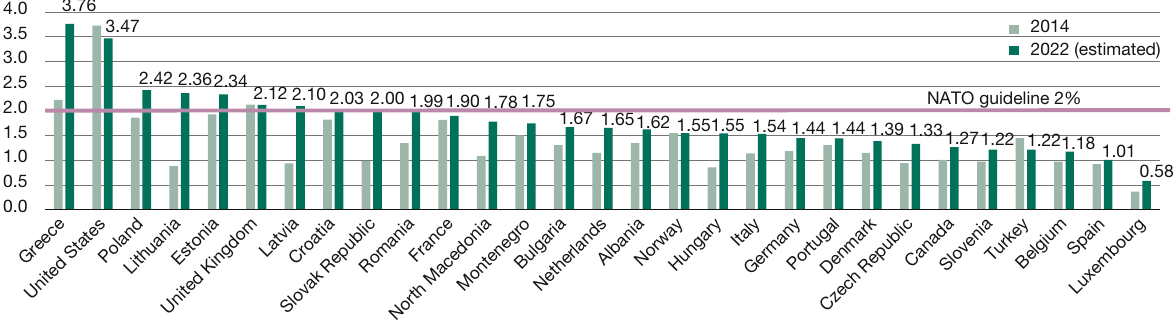
in %, based on 2015 prices and exchange rates